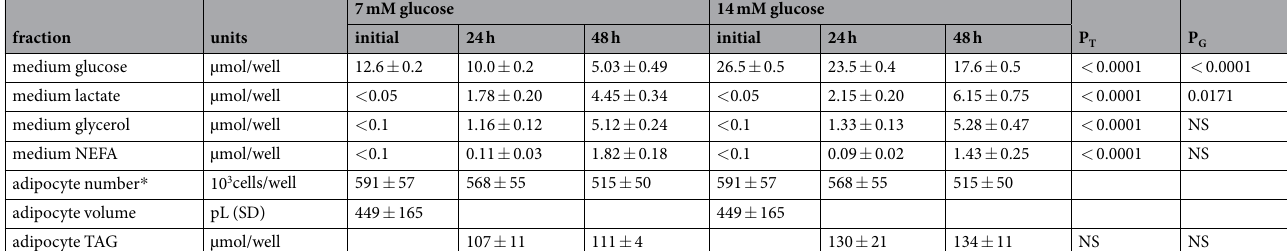
Table 1. Medium levels of glucose, metabolites and cell counts. The data are presented as mean ± sem of eight different two-rat pools (i.e. labelled + parallel). * Estimated values (cell counts were obtained from combined “parallel” well samples). The adipocyte % of lipid (990 g/L) was measured using tissue pooled samples as previously described 35 . The levels of cell TAG were calculated from their lipid content; a standard molecular weight of 884 (i.e. trioleoyl-glycerol) has been used for the calculations. Statistical significance of the differences between groups (2-way-ANOVA). P T represents the effect of time of incubation and P G the effects of initial glucose in the